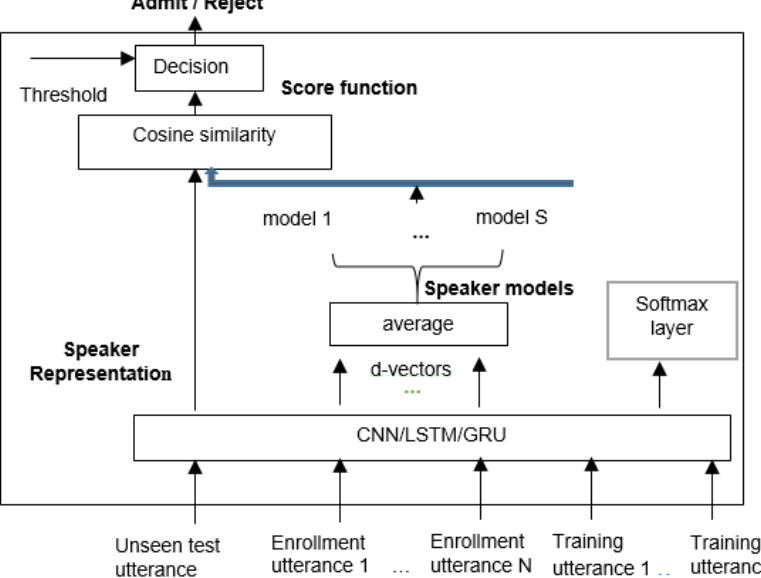
Figure 4. Architecture used for DNN models in speaker verification.